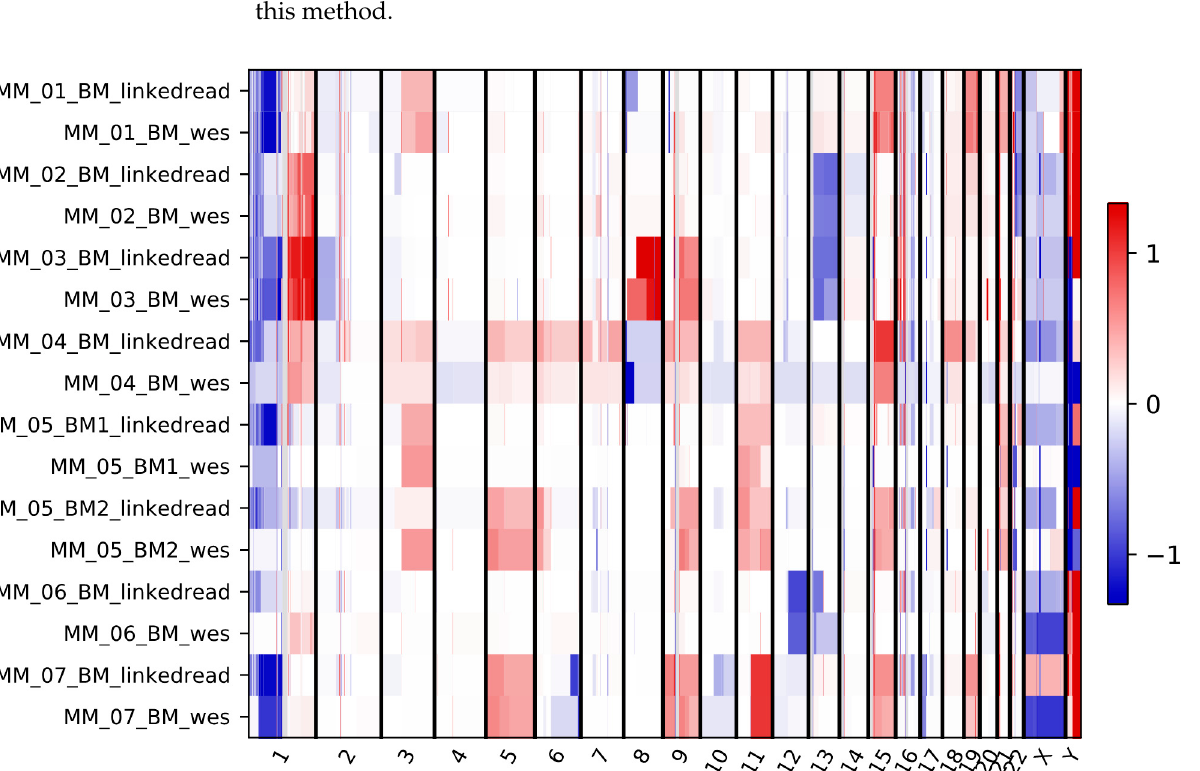
Figure 4. Receiver operating characteristics (ROC) analysis. ( a , b ) ROC curves of FISH-detected clinically relevant cytoge- netics events compared with both linked-read and WES. The area under the curve (AUC) and confidence intervals are shown in the figures. The WES method provided higher AUC values. The x -axis represents specificity, and the y -axis represents sensitivity. ( a ) WES shows an AUC of 0.791 ( b ) Linked-read shows an AUC of 0.766.